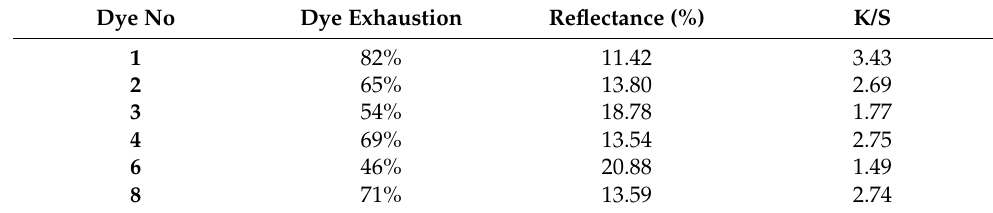
Table 4. Dye exhaustion, reflectance, and color strength of azo disperse dyes on polyester fabrics at λ max . Dye No Dye Exhaustion Reflectance (%) K/S 1 82% 11.42 3.43 2 65% 13.80 2.69 54%